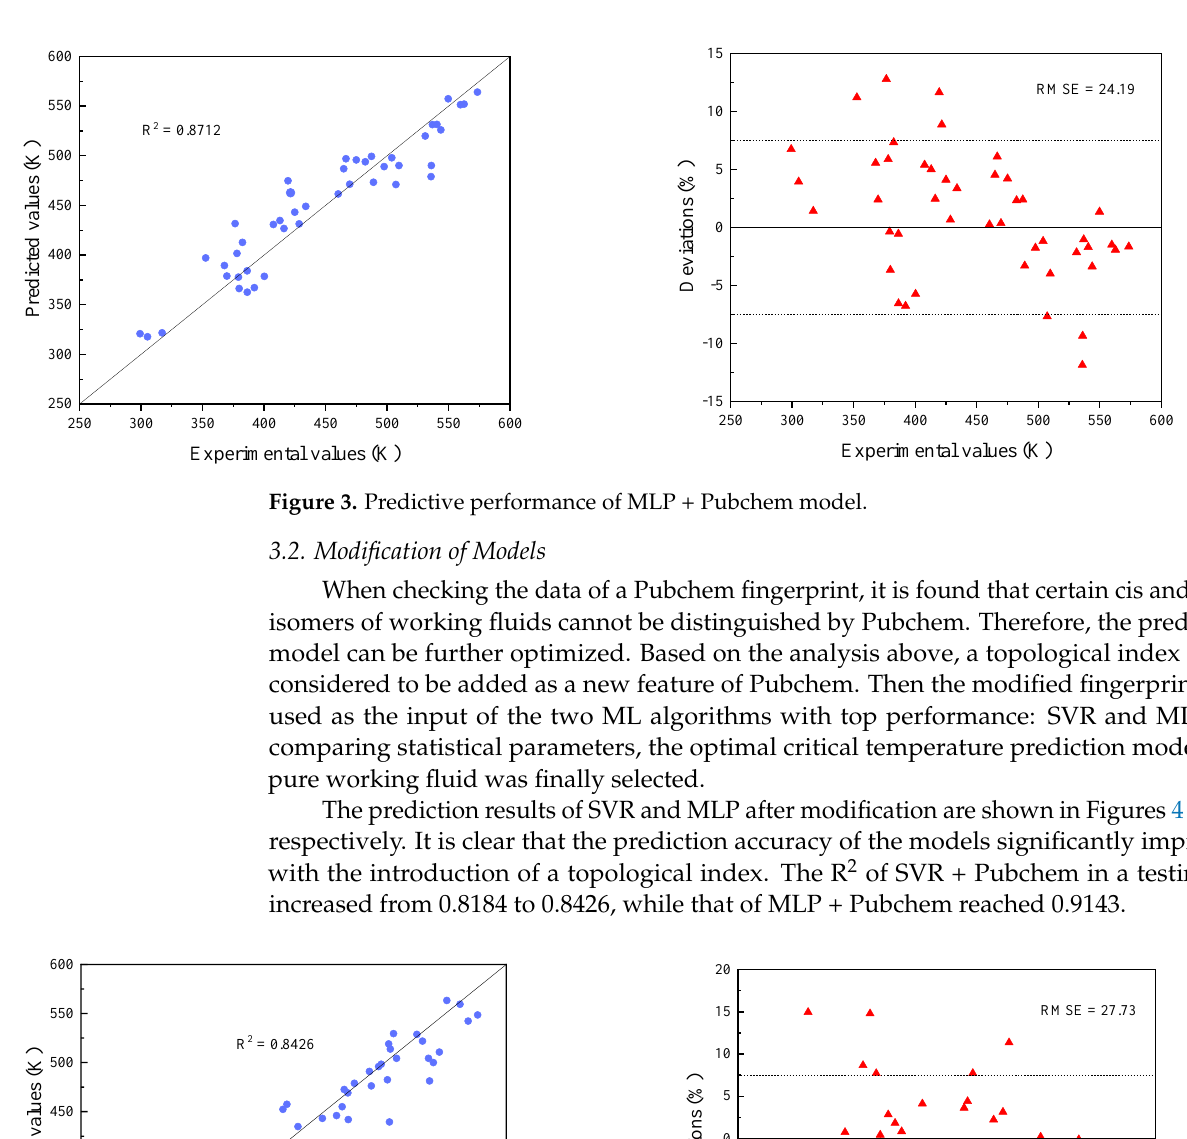
Figure 3. Predictive performance of MLP + Pubchem model.